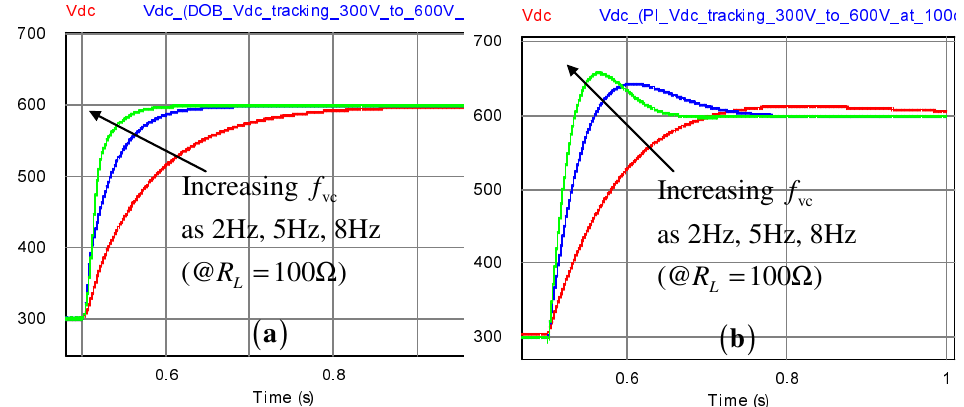
Figure 8. The DC-link voltage tracking behavior comparison between the proposed method ( a ) and the feedback linearizing (FL) method ( b ) by increasing the cut-off frequencies, such as 2, 5, 8